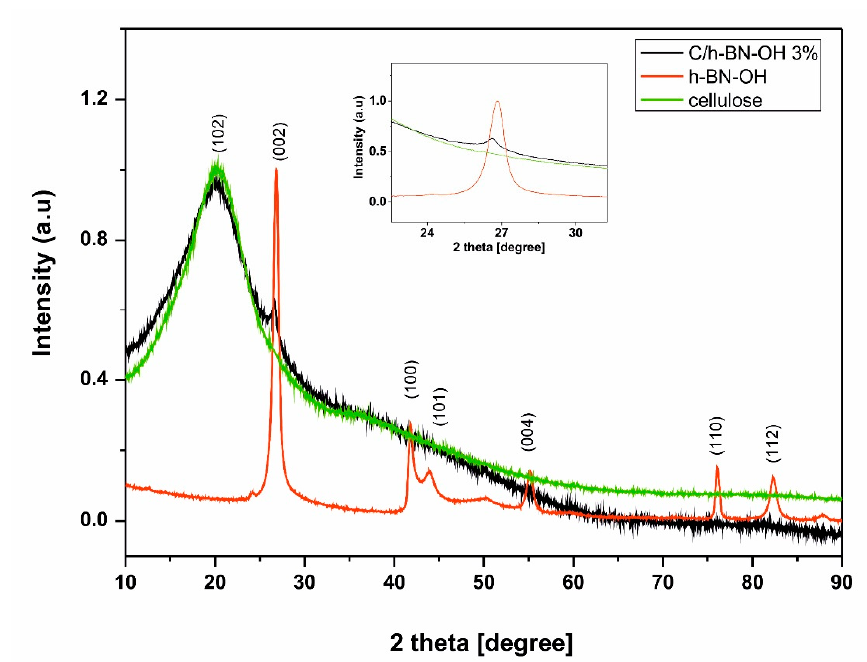
Figure 6. XRD patterns of h-BN-OH nanosheets (red curve) and cellulose fibers before (green curve) and after (black curve) the functionalization process.